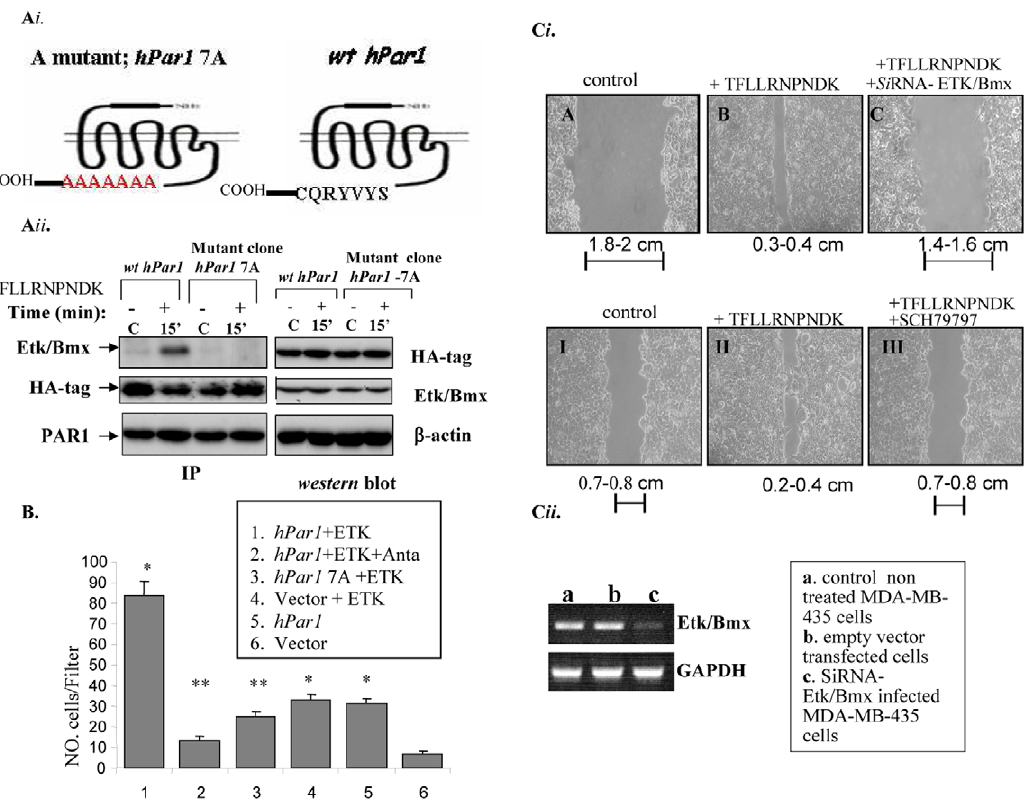
Figure 7. Functional consequences of mutant hPar1-7A versus wthPar1 . A i . Schematic representation of wt hPar1 and the mutant hPar1-7A . A ii . The ectopic expression of hPar1-7A mutant construct abrogates binding of Etk/Bmx to PAR 1 C-tail. Stable clones of either HA-tagged wt hPar1 and/or a mutant construct of HA- hPar1- 7A were activated and further analyzed for co-immunoprecipitation of PAR 1 with Etk/Bmx. The IP was carried out using anti-HA (sc-7392; Santa Cruz, CA). The blots were detected by anti-Bmx (Transduction Laboratories, BD Biosciences, CA) for the identification of Etk/Bmx-associated PAR 1 . Levels of the HA-tag (for PAR 1 ) are shown in the middle panel. Similarly, levels of PAR 1 are also shown by application of anti- PAR 1 (ATAP; Santa Cruz, CA) (lower panel). The right section shows levels of plasmid transfection efficiencies in the cells, as indicated by HA- PAR 1 and Etk/Bmx analysis by western blots. As seen, only the wt hPar1 co-immunoprecipitated with Etk/Bmx ( wt hPar1 ), while the mutant HA- hPar1- 7A clone (mutant clone hPar1- 7A ) failed to co-immunoprecipitate. This takes place under conditions whereby both constructs are well expressed, as evidenced by anti-HA-antibodies (western blot; right panel). B . Matrigel invasion assay of either MCF7 cells stably expressing HA-wt-hPar1and Etk/Bmx, or HA-hPar1-7A mutant and Etk/Bmx. Invading cells were counted and the mean 6 SD of ten fields per filter was determined. Stable HA wt hPar1 clone or HA- hPar1- 7A mutant clone were co-transfected with Etk/Bmx construct and TFLLRNPNDK-activated. Marked Matrigel invasion is seen in the wt hPar1 and Etk/Bmx clones. Low invasion levels are observed in the presence of hPar1-7A mutant and Etk/Bmx, hPar1 alone, empty vector, vector and Etk/Bmx or PAR 1 antagonist. These data are representative of three experiments. C i . Migration assay for wounding-scratch monolayer cells. MDA-MB- 435 cell monolayer (expressing endogenous Etk/Bmx) were scratched to introduce an equal gap-area under the following conditions: control untreated cells, TFLLRNPNDK-activated or Si RNA-Etk/Bmx and TFLLRNPNDK-activated. In this set, rapid closure of the wound was obtained 24 hours under PAR 1 activation as compared to control untreated cells. In contrast, no migration and closure of the wound was seen when the Etk/Bmx level of the cells were knocked down and they were TFLLRNPNDK-activated. In another set of wound introduction experiments, attenuated wound closure was seen in the presence of the V antagonist SCH79797 and SFLLR NPNDK PAR 1 activation for 24 h, similar to the control untreated cells. These data are representative of four experiments. C ii . RT-PCR analysis showing the level of Etk/Bmx in MDA-MB-435 cells before and after SiRNA- Etk/Bmx cell infection.